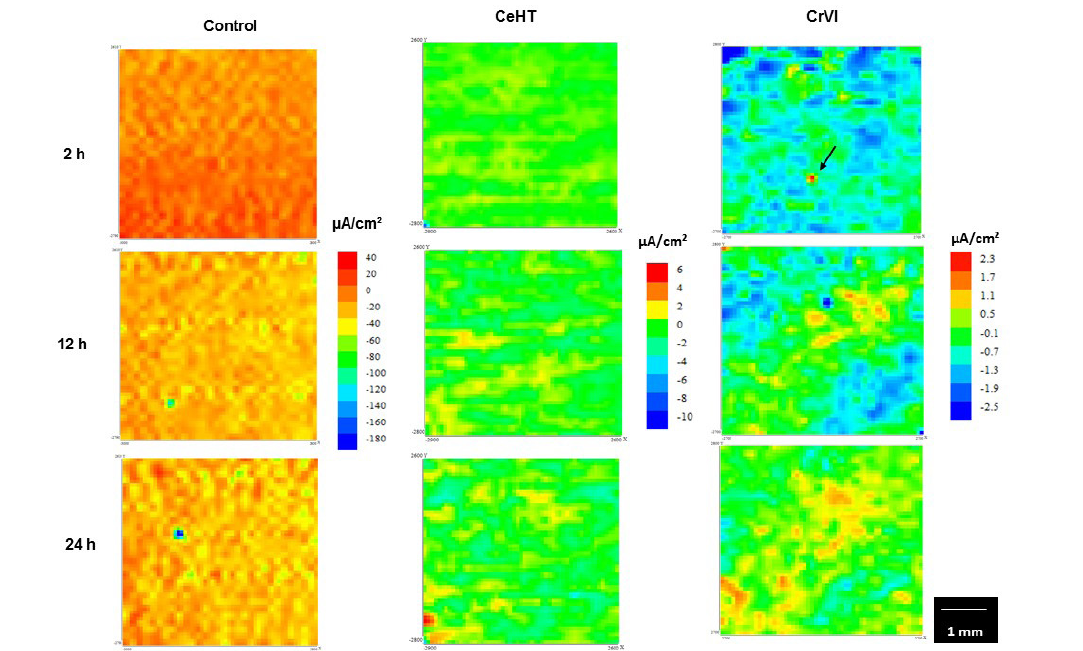
Figure 4. SVET maps obtained for AA1230 clad on AA2024 alloy with various pre-treatments (Control, CeHT and Cr VI) Measurements taken after exposure in NaCl 0.05 mol L -1 for 2 h, 12 h and 24